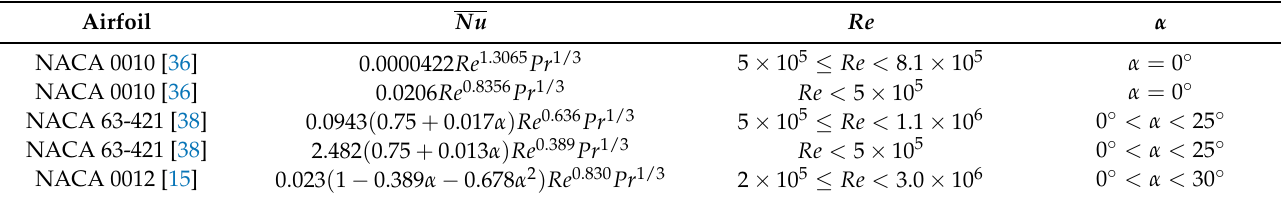
Table 1. Correlations from the